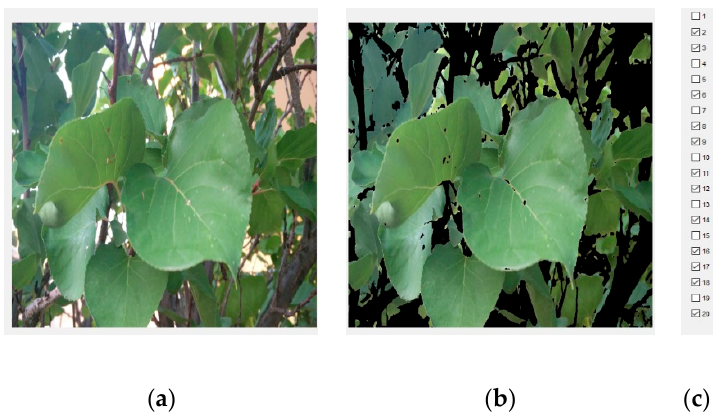
Figure 2. Cluster classification example. ( a ) original image; ( b ) mask overlaid to original image; ( c ) checkboxes for cluster classification.